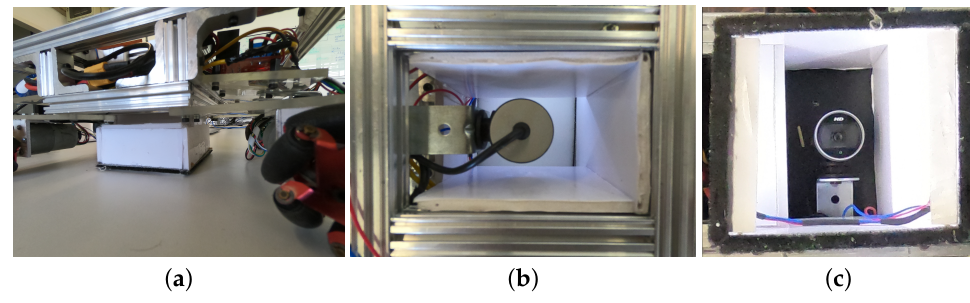
Figure 14. Camera lighting box. ( a ) a lateral view of the box; ( b ) box top view; ( c ) view from the bottom. The LEDs strips are at the image apex and bottom, pointing upwards.